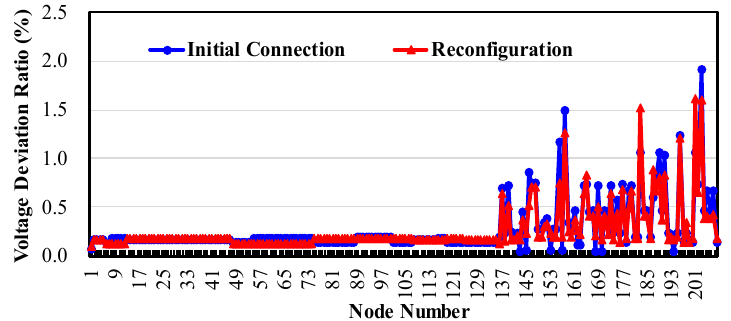
Figure 9. Comparison of voltage deviation for each node of the TPC test system.